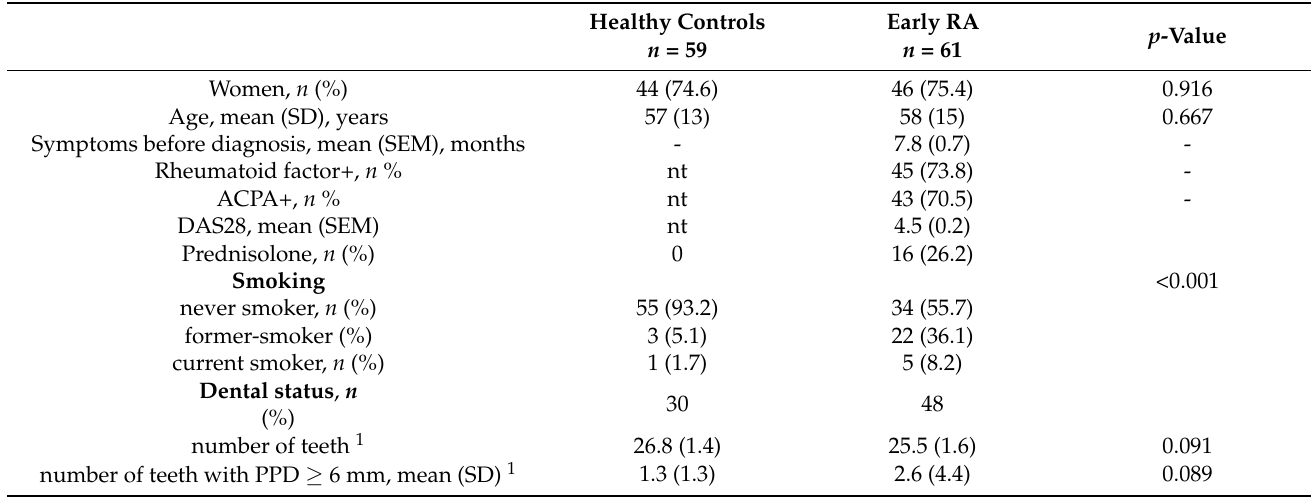
Table 1. Participant characteristics for the early onset RA group and healthy controls sampled for saliva microbiota